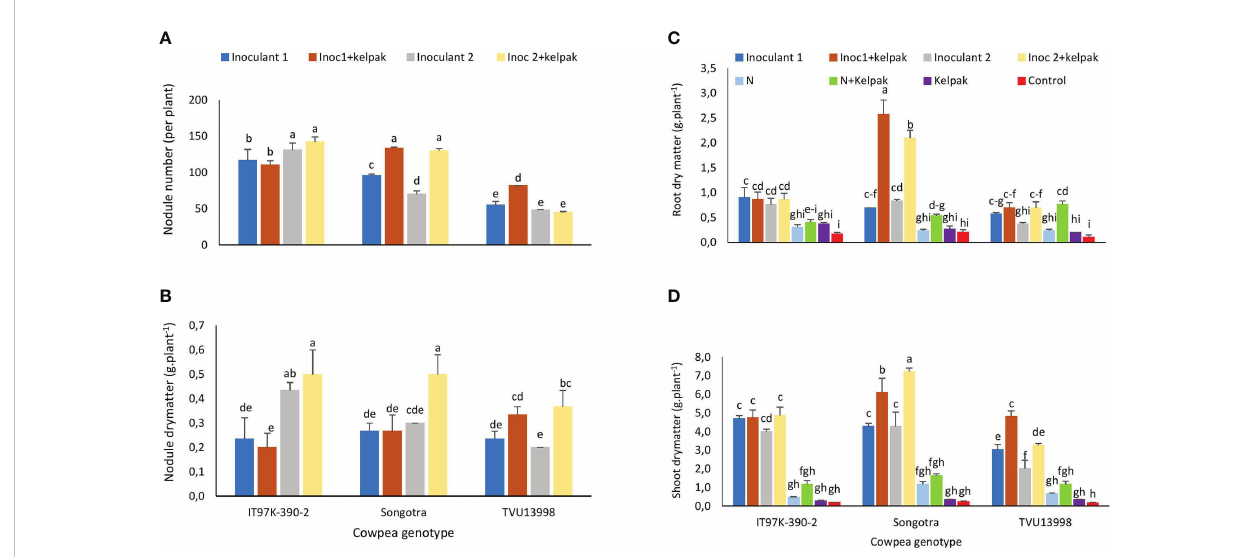
FIGURE 1 Interactive effect of genotype x treatment on nodule number (A) , nodule dry matter (B) , root dry matter (C) and shoot dry matter (D) of three cowpea genotypes, planted under glasshouse conditions. Inoculant 1(Inoc 1) = B . yuanmingense strain CB756 (commercial inoculant), Inoculant 2 (Inoc 2) = Bradyrhizobium sp. strain TUTVUSA (closely related to B . daqingense ), control = no inoculant and no kelpak, N= 5mM KNO 3, control= no inoculation and no kelpak. Vertical lines on bars represent S.E. Bars followed by dissimilar letters are signi fi cant at ***p ≤